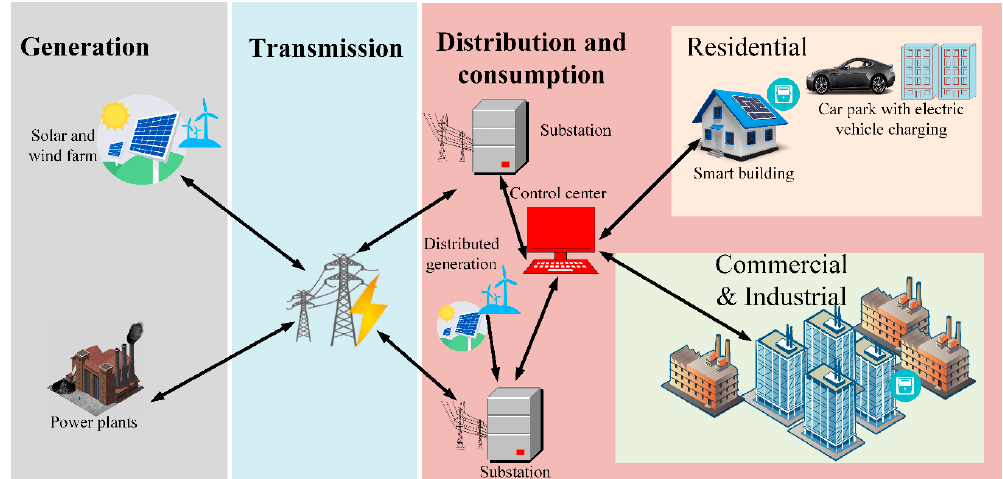
Figure 11. Schematic of a smart city utilizing the SG concept. SG provides integration of renewable energy resources (RESs) into the main grid and more controllability over the grid system. It also enables bi-directional power flow between the grid and consumption side [82].